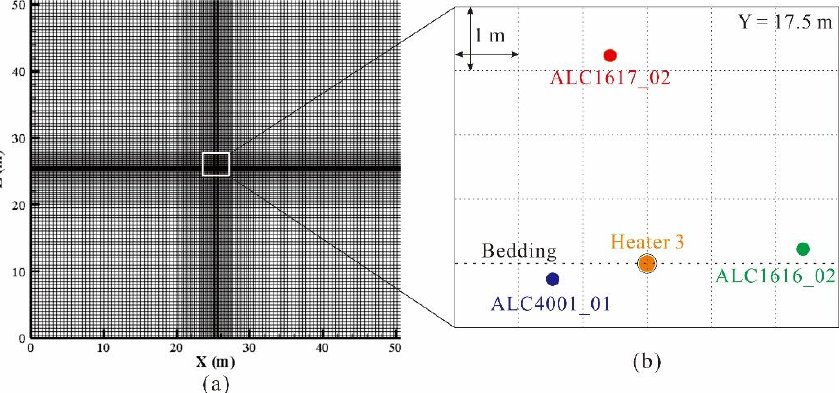
Figure 7. ( a ) The numerical grids used in the 2D simulation and ( b ) the distribution of monitoring boreholes surrounding the Heater 3.